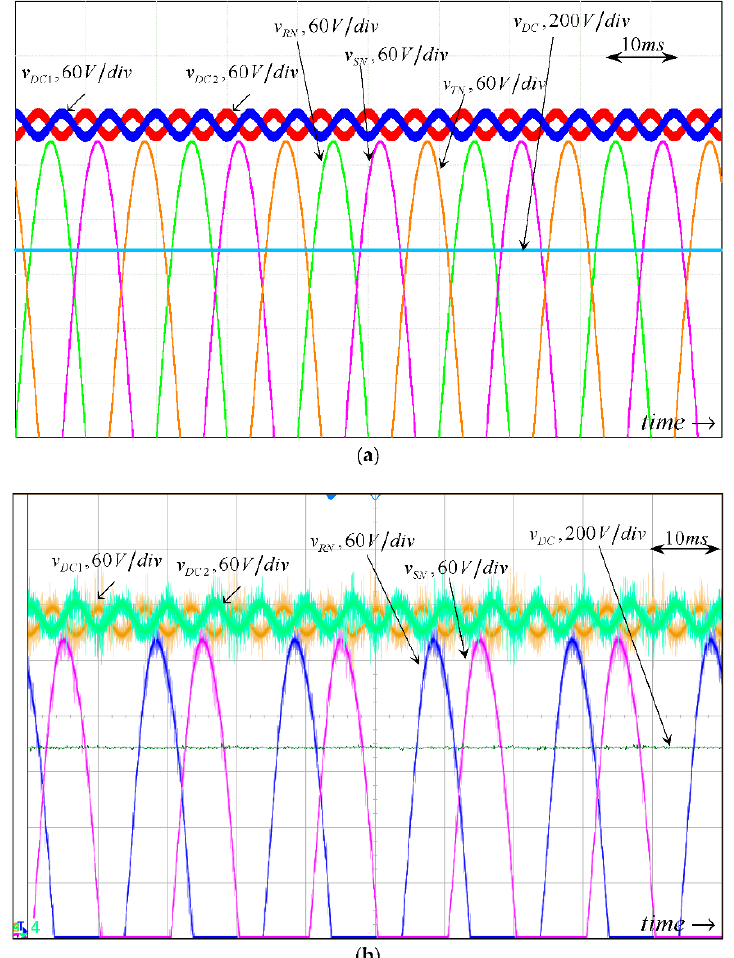
Figure 8. Results of capacitor voltage rating imposed design. ( a ) Simulation. ( b ) Experiment.